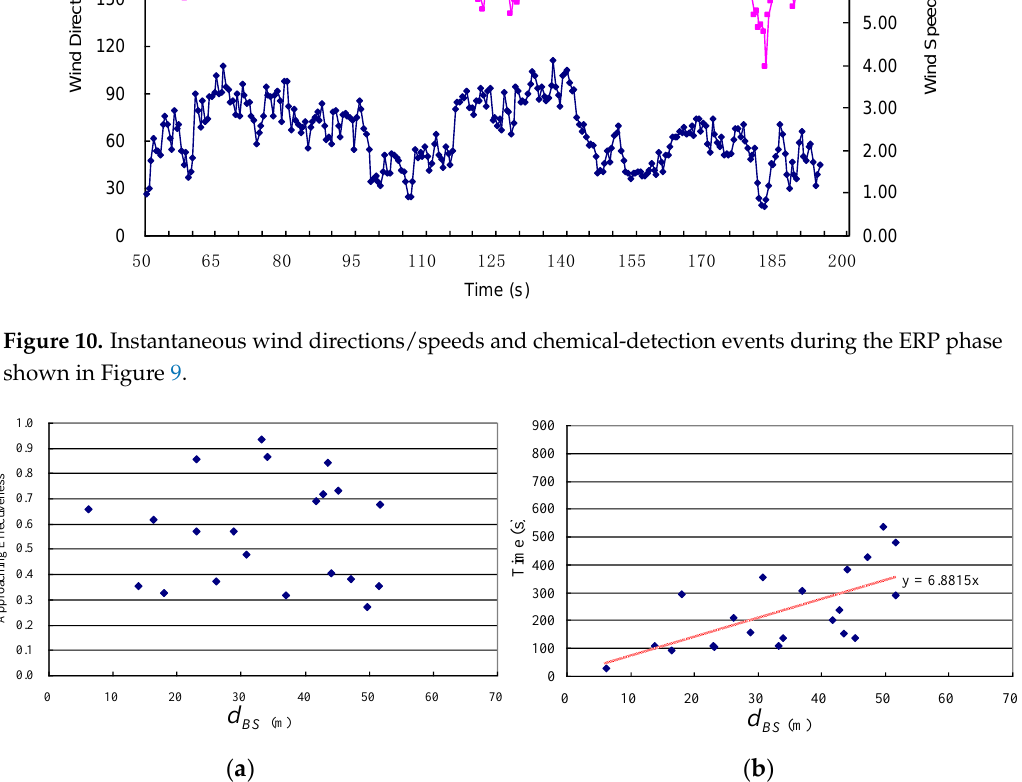
Figure 11. Results of 21 ERP experiments in the F group. ( a ) Approaching effectiveness. ( b ) Time costs. Each mark in the two subgraphs stands for the corresponding value of an experiment.